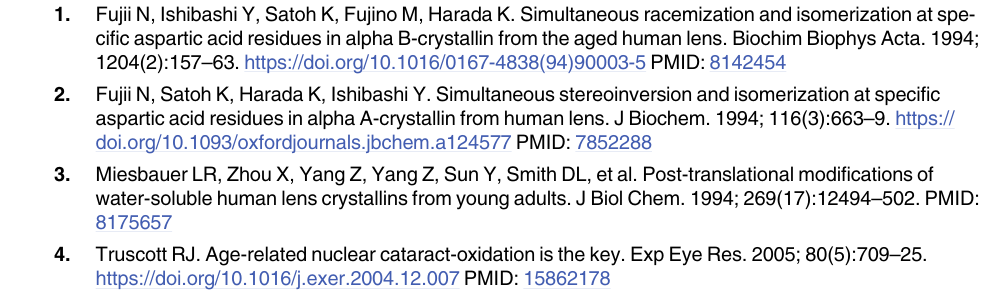
isoAsp76). These showed the activity of PIMT for L-isoAsp76 containing peptide in current experiments. S2 Fig. Emission spectra of ThT solution in the presence of the H79A α A66–80 (L-Asp76) and H79A α A66–80 (L-isoAsp76) peptides. (TIFF) S3 Fig. Comparison of the secondary structure of α A66–80 (L-isoAsp76) and D76A α A66– 80 peptides. (A) Far-UV CD spectra of α A66–80 (L-isoAsp76) (black) and D76A α A66–80 (red). (B) The fluorescence spectra of ThT in the presence of α A66–80 (L-isoAsp76) (black) and D76A α A66–80 (red). (TIFF) S1 Table. Molar masses of each alanine substituents.